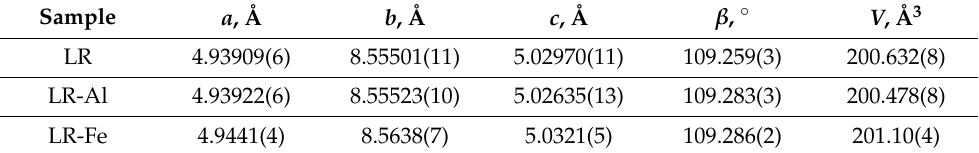
Table 2. Refined unit cell parameters of LR, LR-Al, and LR-Fe materials (space group C 2/ m ).